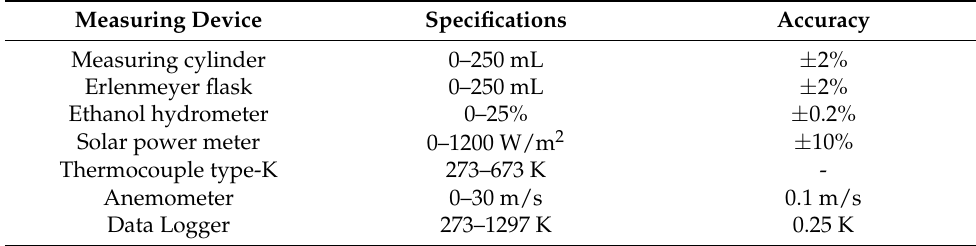
Table 2. Measuring devices used in the